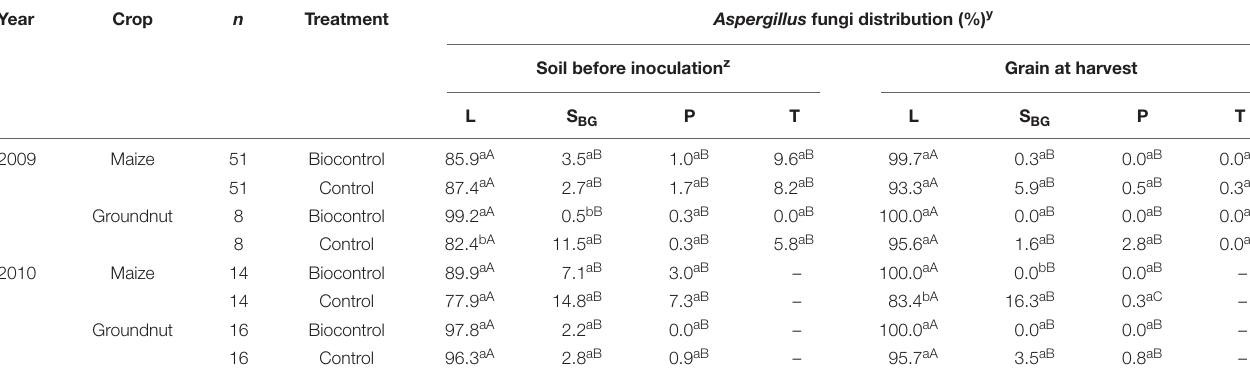
TABLE 3 | Frequencies of Aspergillus section Flavi fungi in soil before biocontrol application, and in maize and groundnut grains from biocontrol -treated and control fields during 2009 and 2010. Year Crop n Treatment Aspergillus fungi distribution (%) y Soil before inoculation z Grain at harvest